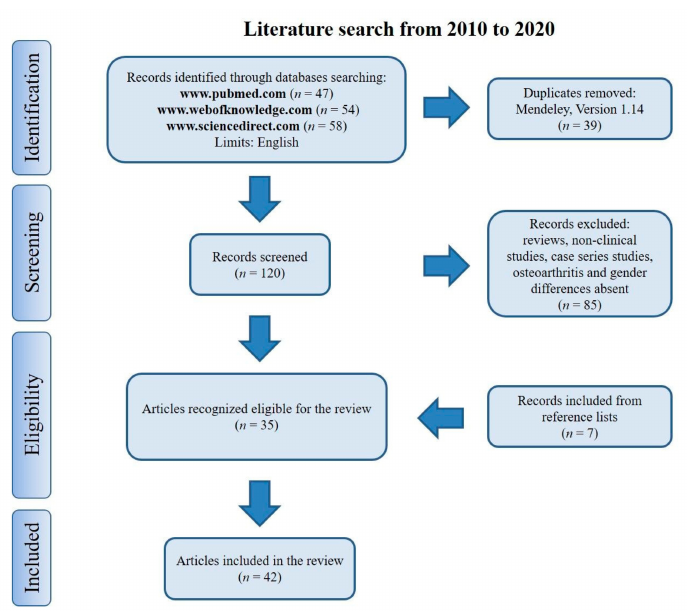
Figure 1. Search strategy according to the Preferred Reporting Items for Systematic Reviews and Meta-Analyses (PRISMA) statement.